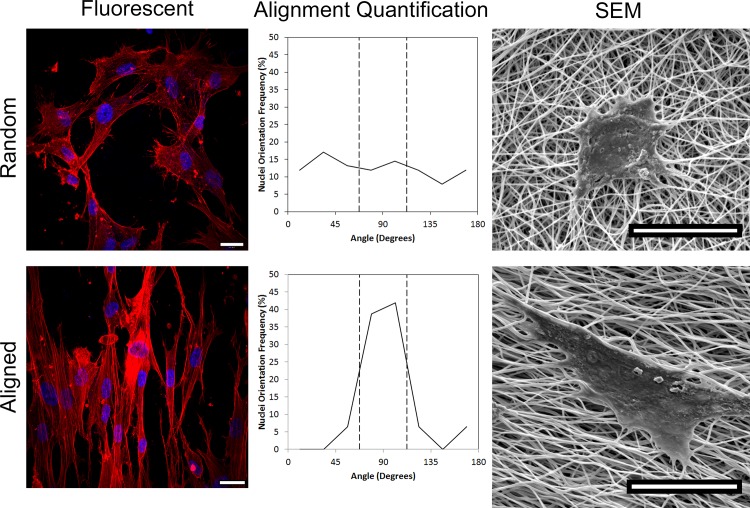
Microscope images showing cells growing on random (top) or aligned (bottom) electrospun PCL+Gel fibers.Fluorescent images are shown on the left with the cells stained to show the nuclei and stress fibers. The central column shows the distribution of cell orientations, confirming the cells on aligned fibers have a preferred orientation. Electron microscope images are shown on the right to illustrate the cellular interactions with the substrate. All image scale bars are 20μm.